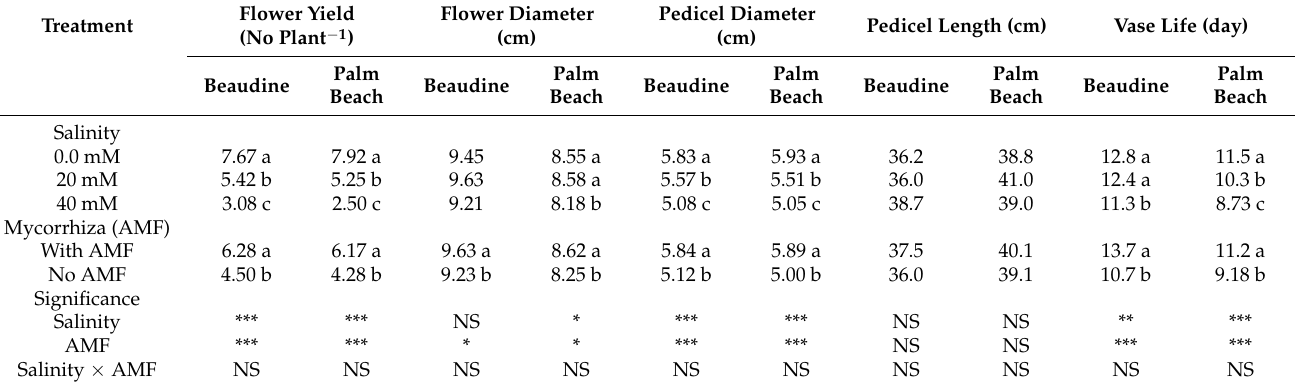
Table 4. Flower yield and quality component of gerbera cultivars (‘Beaudine’ red; ‘Palm Beach’ yellow) inoculated (AMF) or uninoculated (No AMF), grown under different salt stress levels in 2019.